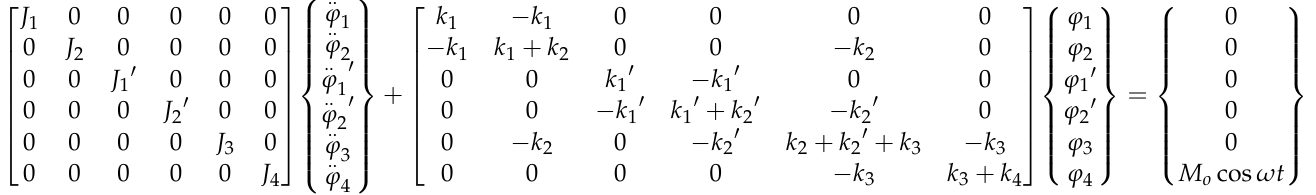
Figure 2. The representation of the function )(P ω . The five values obtained for the considered data represent frequencies for which, upon excitation with a harmonic moment with an amplitude of 100 Nm acting on